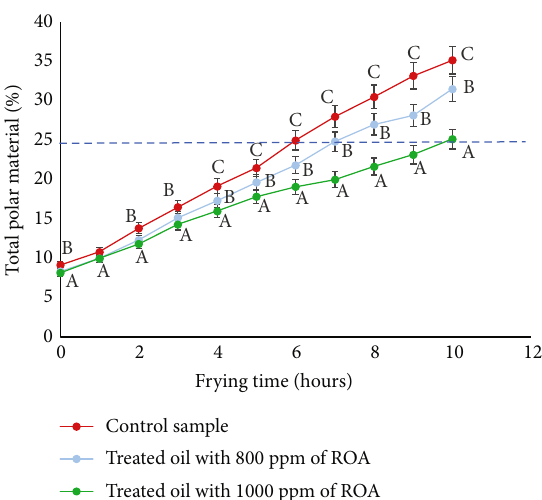
Figure 1: Formation of total polar materials during frying of breaded shrimps in soybean oil. The values followed by di ff erent letters (A, B, and C) are signi fi cantly di ff erent from each other at p < 0 : 05 .